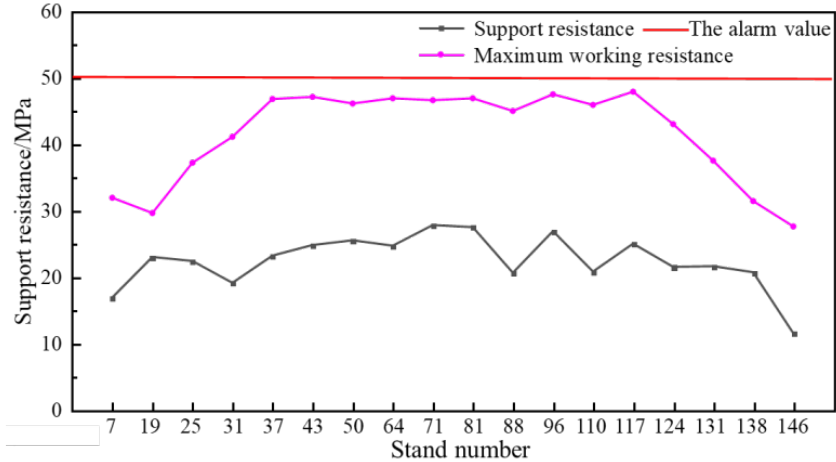
Figure 13. Resistance data monitoring chart of fully mechanized mining.